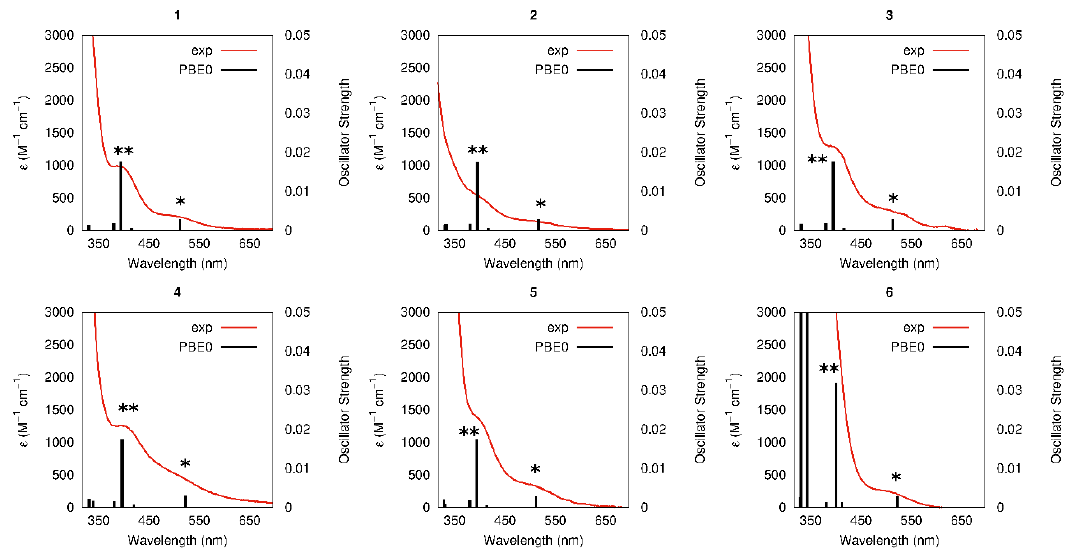
Figure 6. TD-DFT excitations (black lines) plotted against the UV − visible absorption spectra (red) in dichloromethane for complexes 1 – 6 . The excitations reported in Table S2 are highlighted (*/**).